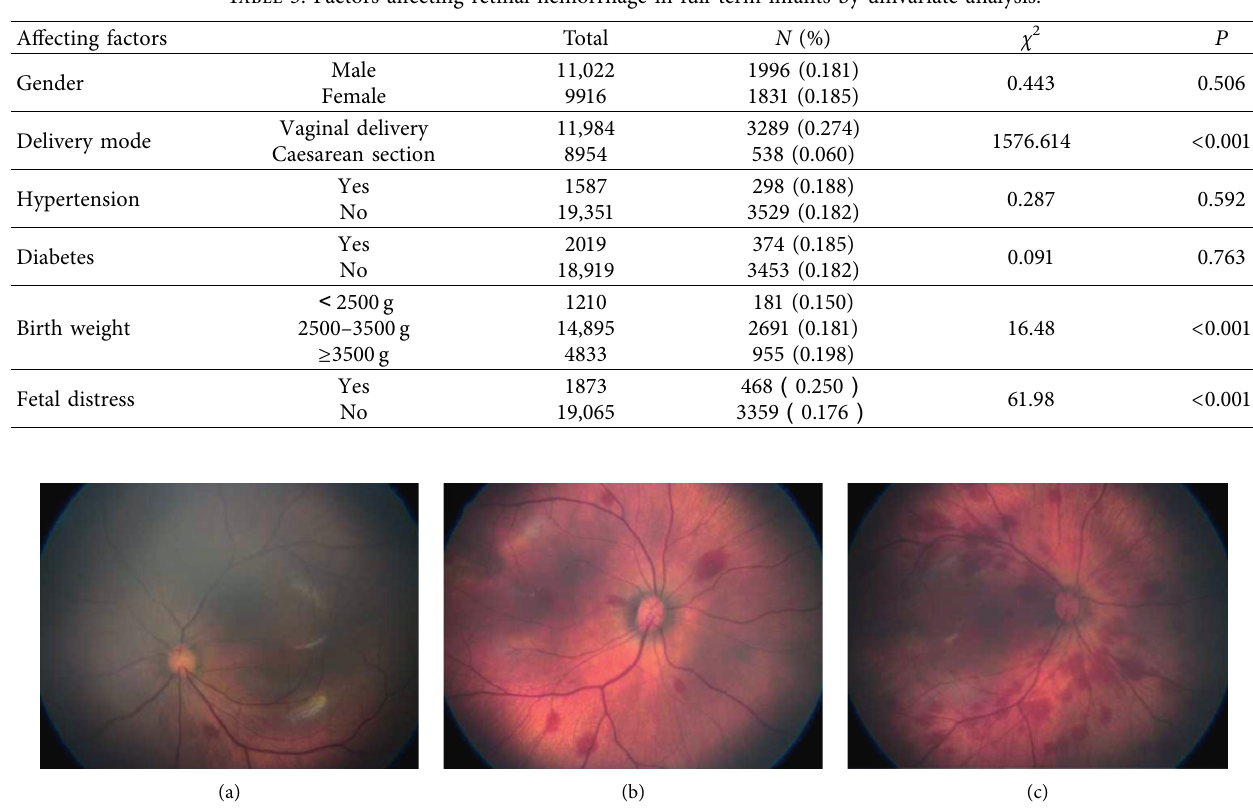
Figure 2: Different degrees of retinal hemorrhage were detected in newborns. (a) Grade I retinal hemorrhage. (b) Grade II retinal hemorrhage. (c) Grade III retinal